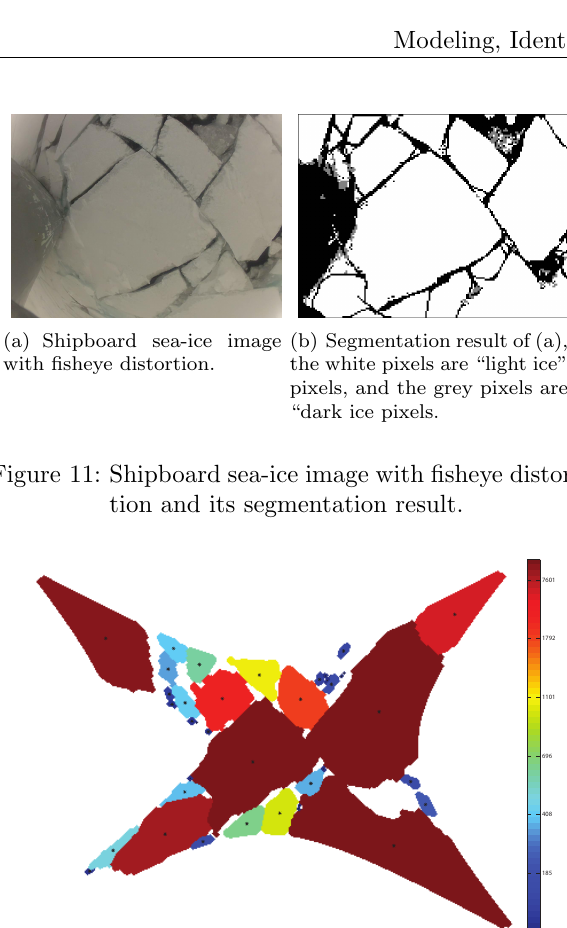
Figure 12: Floe and brash ice size distribution of Fig- ure 11(b).